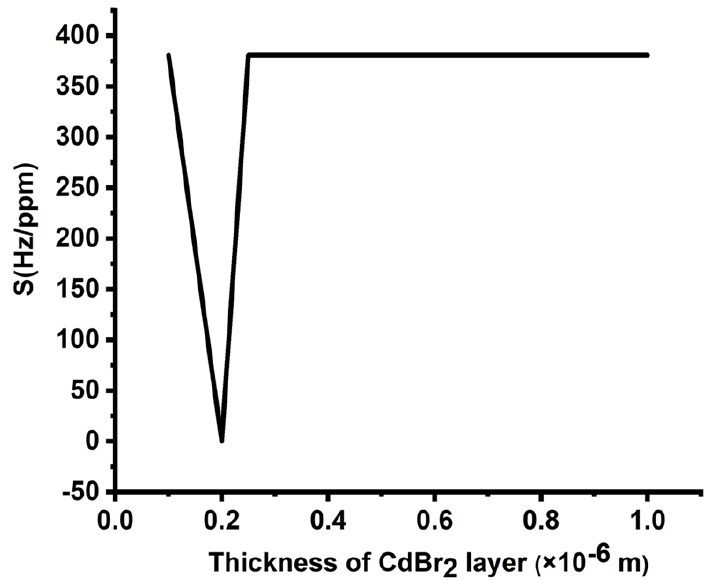
Figure 4. Sensitivity of the designed sensor at different thicknesses of the CdBr 2 layer.